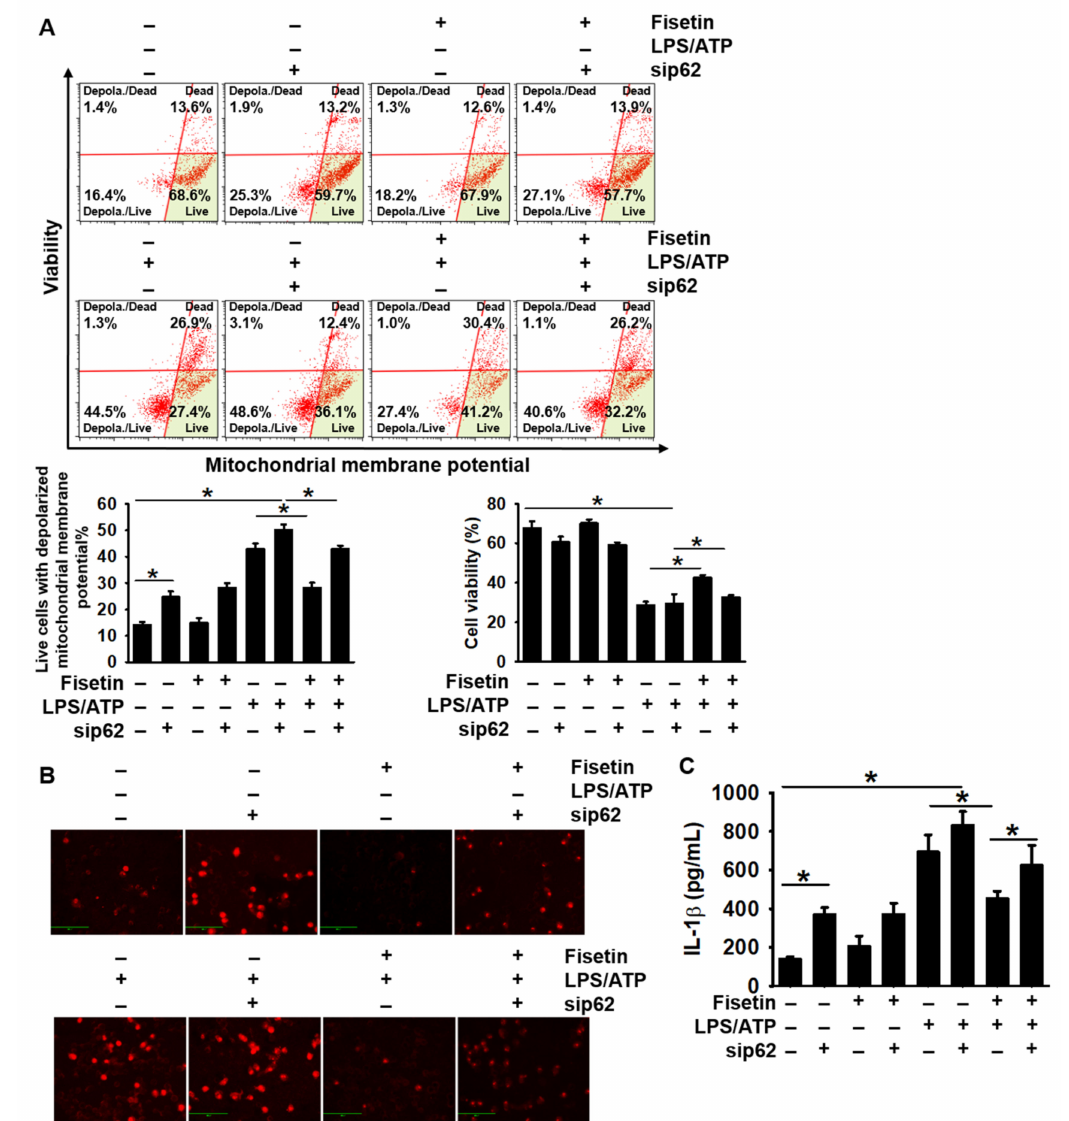
Figure 6. Transient knockdown of p62 aggravates the fisetin-induced stabilization of mitochondrial membrane potential. BV2 microglial cells were transiently transfected with p62 siRNA (sip62) for 48 h and subsequently treated with 1 µ g/mL LPS for 2 h, followed by stimulation with 1 mM ATP (LPS/ATP) for 2 h. ( A ) The population of cells with depolarized mitochondrial membrane potential was measured using a Muse MitoPotential Kit. The total population of live cells with depolarized mitochondrial membrane potential ( bottom left ) and cell viability ( bottom right ) is depicted. ( B ) In a parallel experiment, cells were stained using 2 µ M MitoSOX Red. Images of cells were captured using a CELENA S Digital Imaging System. ( C ) Extracellular level of IL-1 β were quantified using ELISA after 48 h of stimulation of LPS/ATP. The results indicate the mean ± standard error median (SEM), and is representative of the results obtained from three independent experiments.* p <